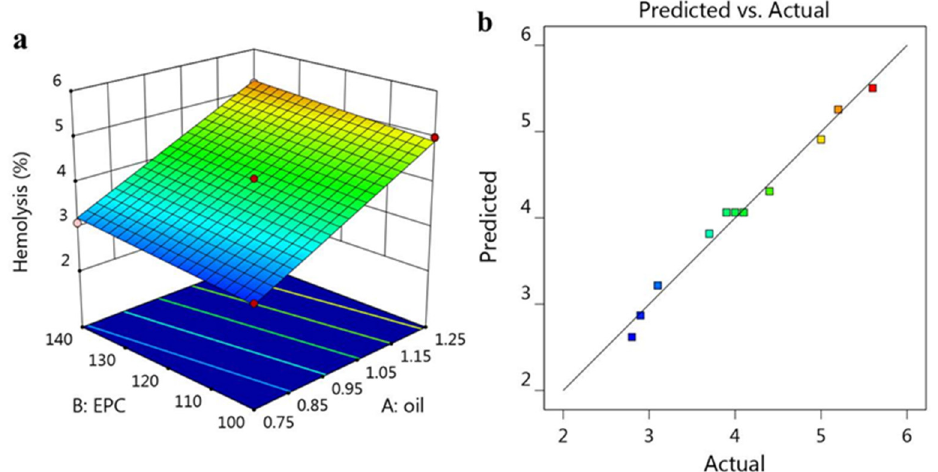
Figure 3. ( a ) 3D-response surface plot and ( b ) linear correlation plot between predicted versus actual